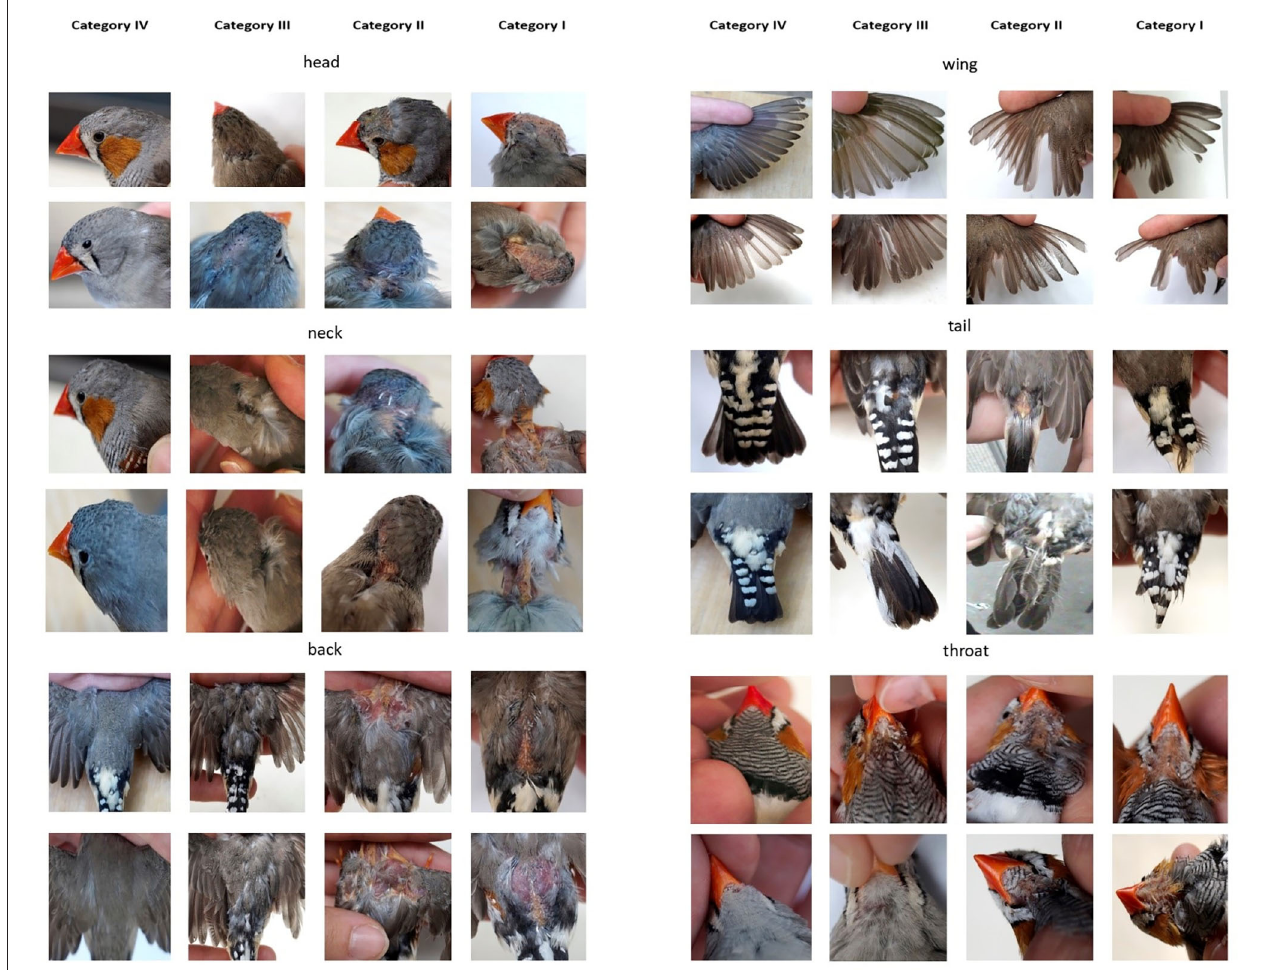
FIGURE 2 | Systematic examples of the respective plumage scores for each scoring category at each of the six plumage regions of Zebra Finches.